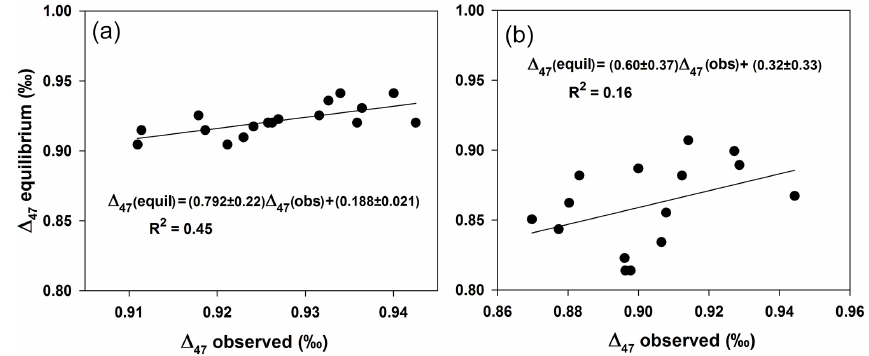
Figure 4. Correlation between the observed and thermodynamic equilibrium (cid:49) 47 values for greenhouse CO 2 samples collected when (a) pho- tosynthesis was weak and respiration was strong and (b) photosynthesis was strong and respiration was weak. Table 2. Stable carbon and oxygen isotopic composition and clumped isotopes ( (cid:49) 47 ) for car exhaust CO 2 . Temperatures estimated using (cid:49) 47 values and lowest possible combustion temperatures are given. Car